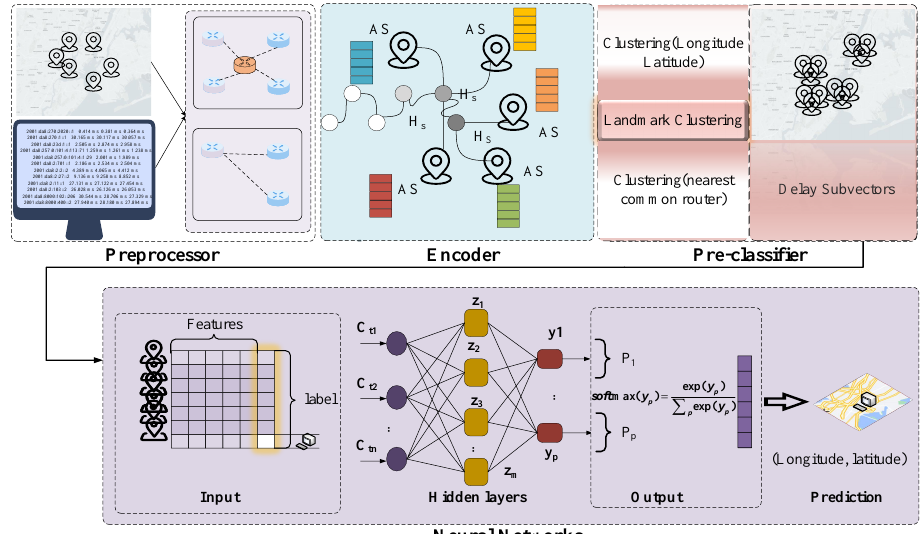
Figure 2. Overview of the proposed IP geolocation